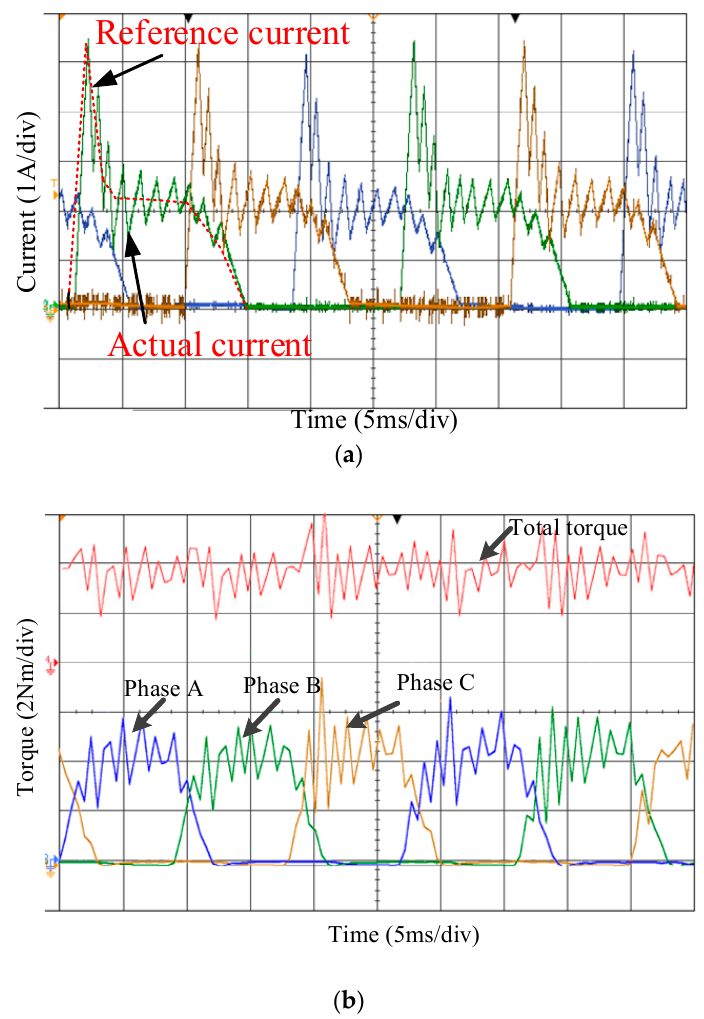
Figure 15. Experiment results with conventional current hysteresis control (hysteresis band is 0.1 A) based on linear TSF ( a ) Current profile ( b ) Phase torque profile and total torque profile.